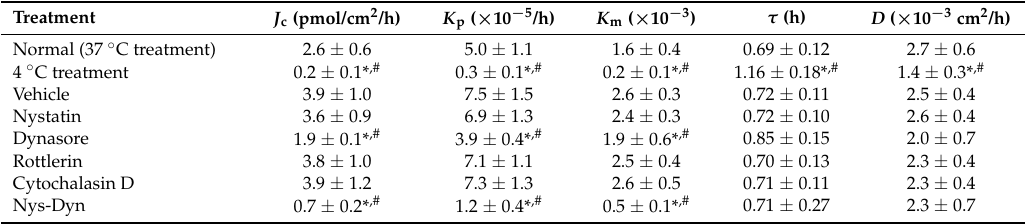
Table 1. Pharmacokinetic parameters for IND-NPs penetration in jejunum treated under cold (4 ◦ C) temperature conditions or with endocytosis